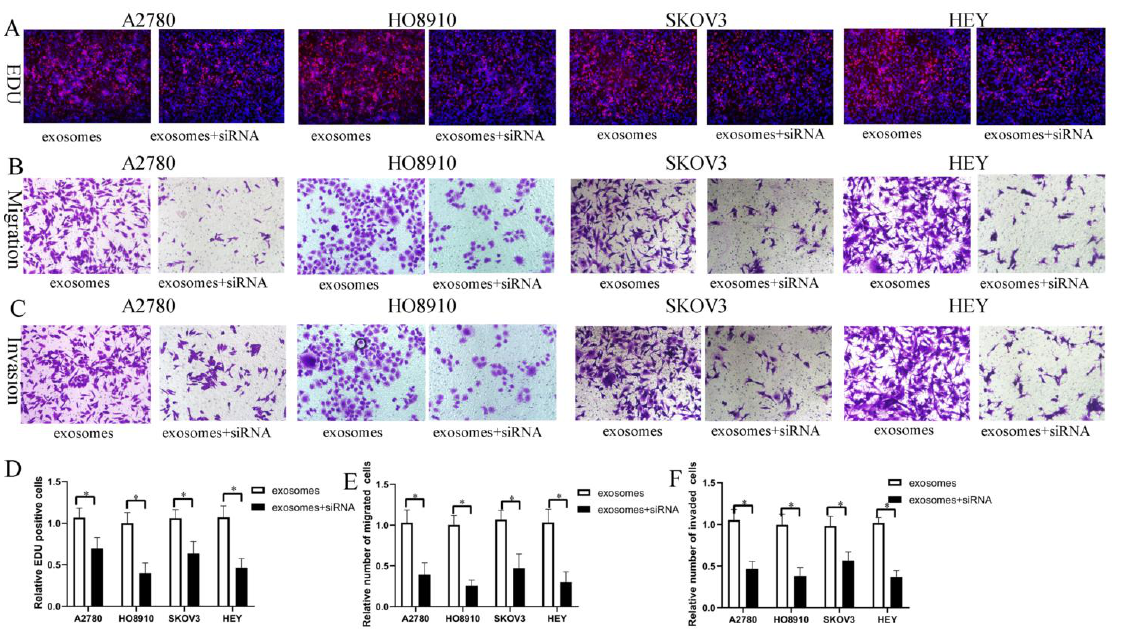
Figure 6. FOXM1 knockdown decreased HO-ADSC-exosome-mediated promotion of EOC cell proliferation, migration, and invasion in vitro. ( A ). The influence of FOXM1 silencing on human EOC cell proliferation was measured by EdU assay. ( B ). Influence of FOXM1 silencing on human EOC cell migration was measured by Transwell assay. ( C ). Influence of FOXM1 silencing on human EOC cell invasion was measured by Transwell assay. ( D ). Quantification of proliferation rates showed that the proliferative capacity of human EOC cell lines was significantly decreased after FOXM1 silencing. ( E ). Quantification of the migrated cells showed that human EOC cell migratory capacity was significantly decreased after FOXM1 silencing. ( F ). Quantification of the invasion rates of human EOC cell lines showed that the invasive capacity of human EOC cell lines was significantly decreased after FOXM1 silencing. * p < 0.05, n = 3.